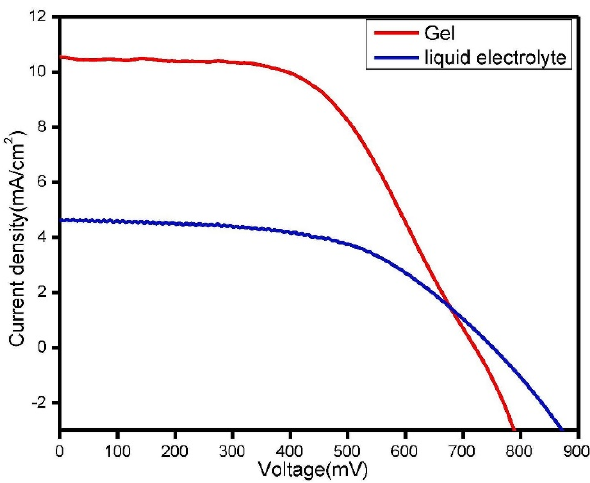
Figure 7. Under the illumination of simulated solar light, photocurrent voltage curves for devices containing liquid electrolyte and GG (0.6 g)-modified GPEs were measured, and adapted from reference [73]. [Reproduced with kind permission]. Table 1. List of performance characteristics of various modified gel-polymer DSSCs.